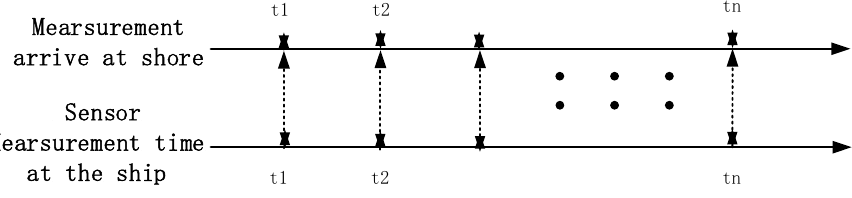
Figure 1. The ship–shore sensor measurement without delay.